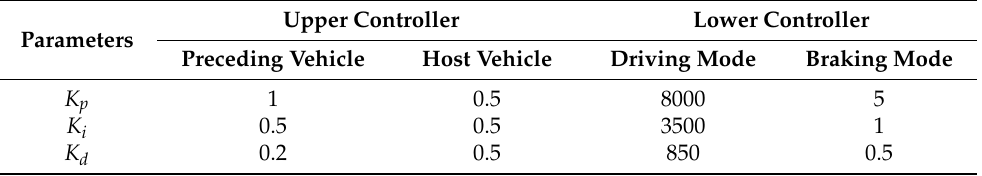
Table 4. The conventional PID controller parameters.